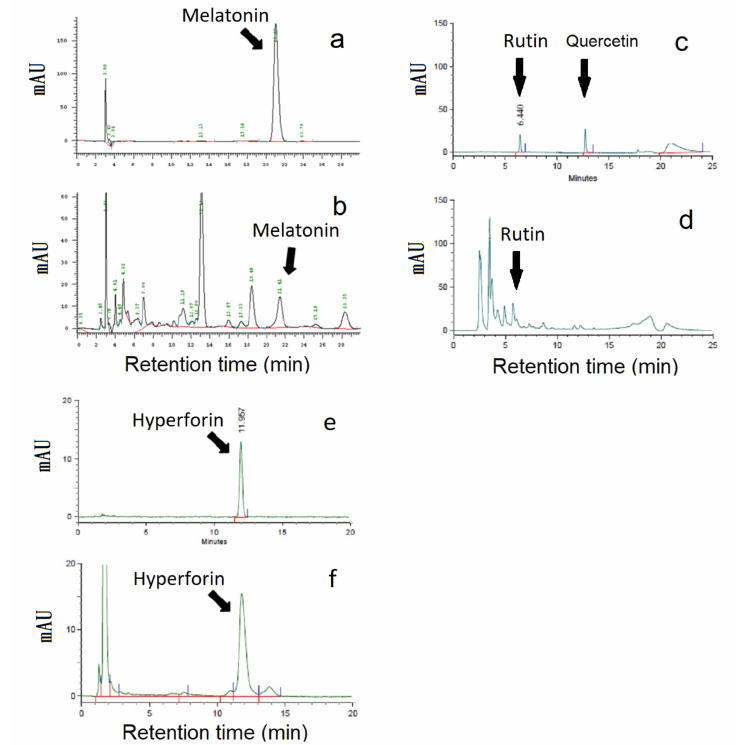
Figure 2. Representative HPLC chromatograms of standard ( a ) melatonin, ( c ) rutin, and ( e ) hyperforin and of St. John’s wort leaf extracts ( b ) melatonin, ( d ) rutin, and ( f ) hyperforin. The arrows indicate the peaks of target compounds in the HPLC